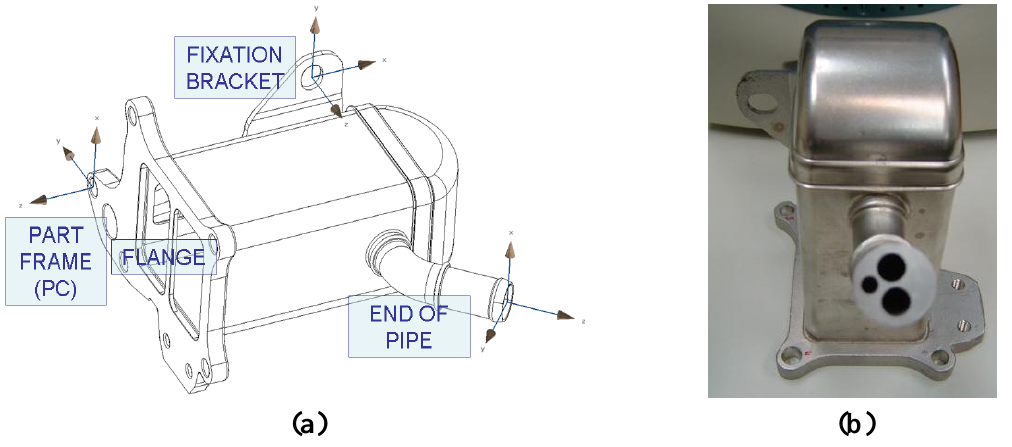
Figure 12. (a) Elements local frames in the master piece. (b) Master piece end of pipe.